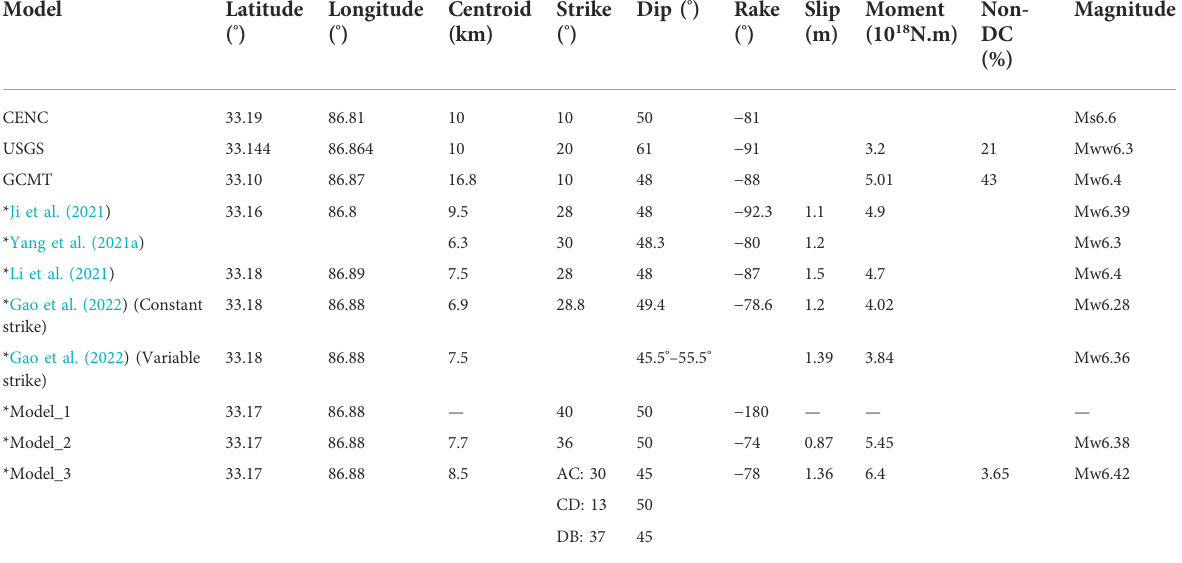
TABLE 1 Fault plane parameters for the mainshock from InSAR studies, and as listed in the CENC, USGS, and GCMT Catalogs.